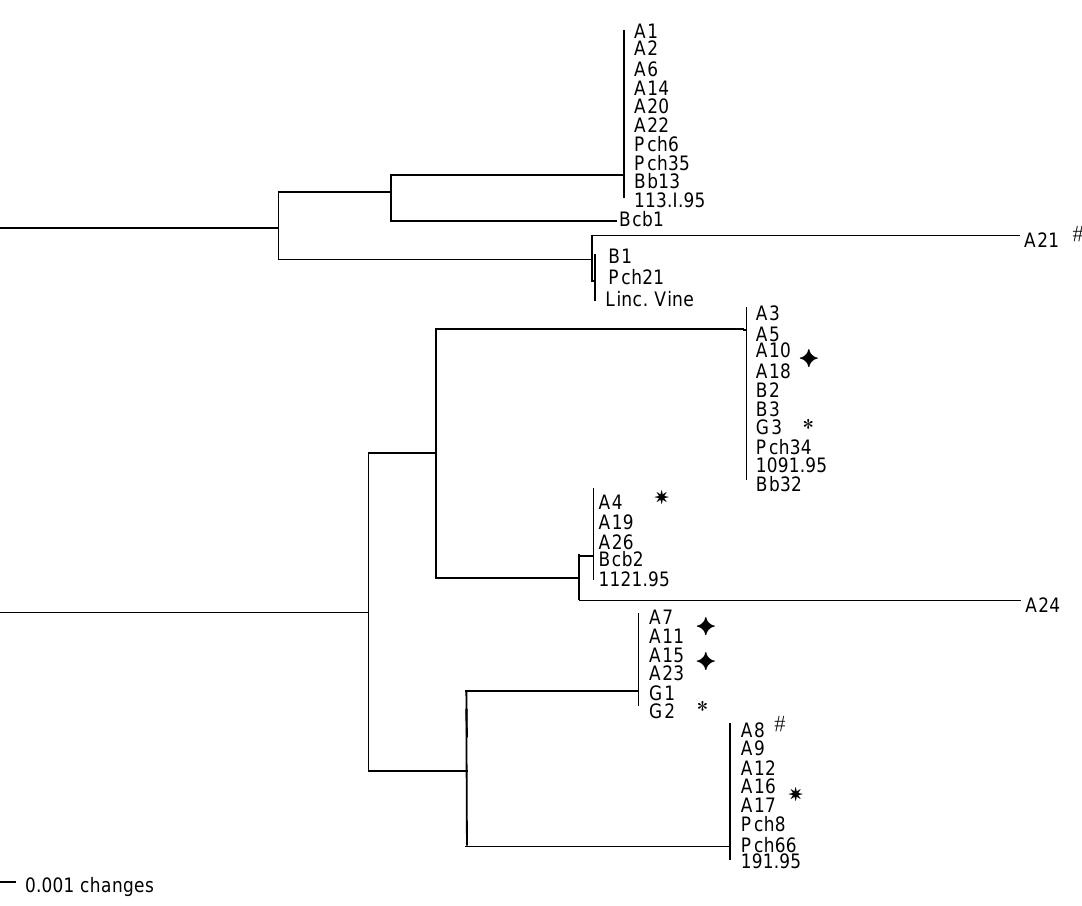
Fig. 4. Neighbour joining dendrogram generated by cumulative binomial tables using UP-PCR primers. Matching symbols on the right of isolates indicate that the isolates were from the same vine. The value indicates the propor- tion of changes for a given number of bands used in the analysis (Paterson A., personal communication,